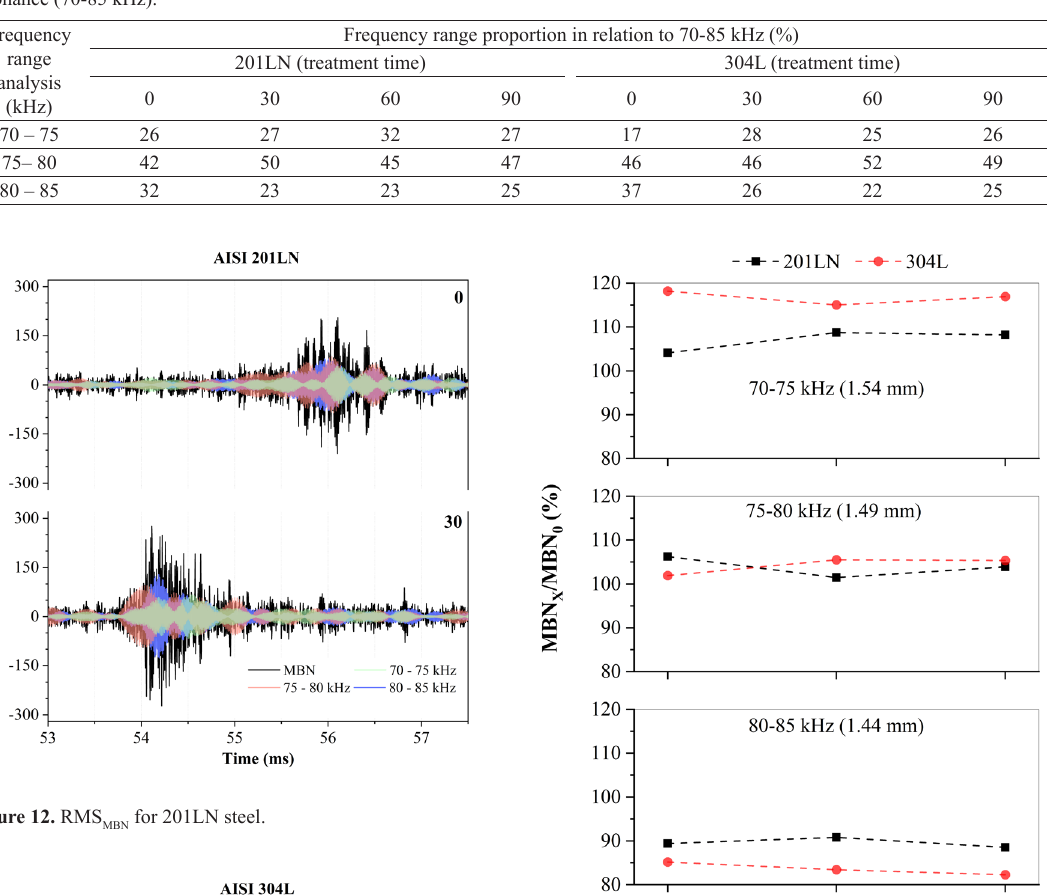
Figure 14. Proportion of RMS conditions using bandpass filter methodology.